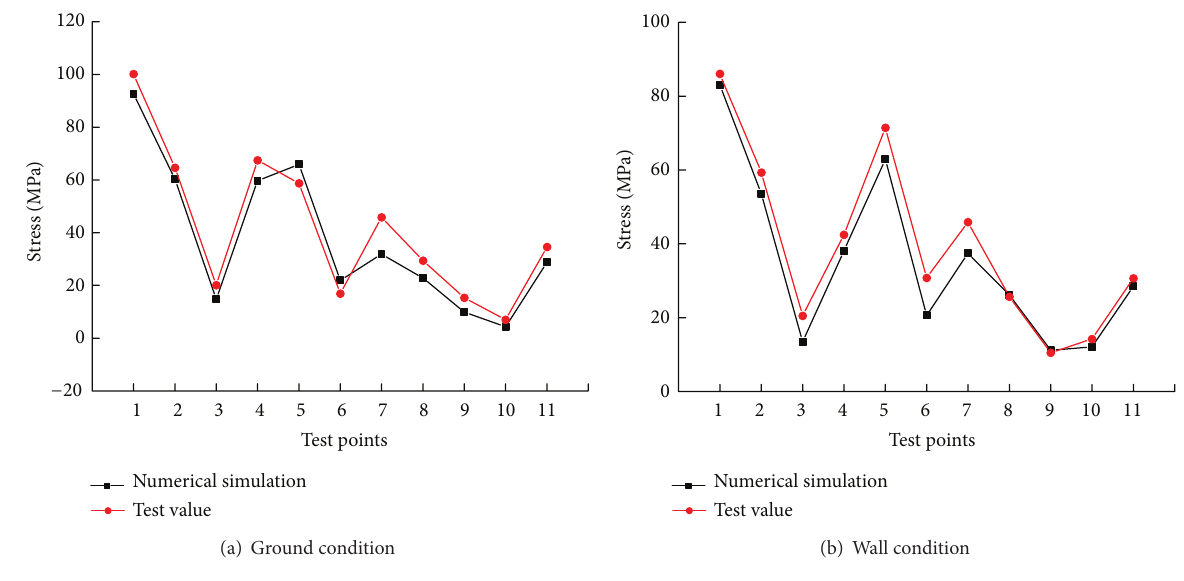
Figure 12: Stress comparison between test and numerical results of the